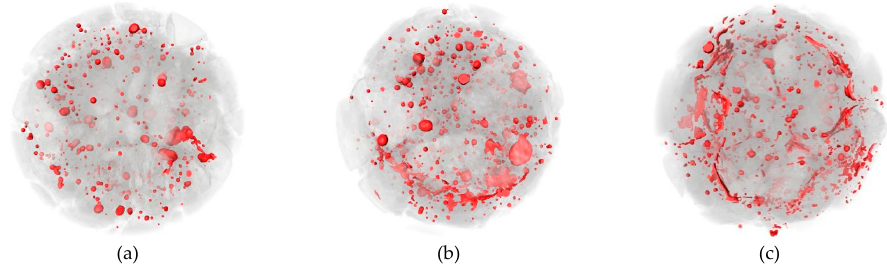
Figure 18. Pore distribution under different freezing and thawing cycles of 0.4% 30 nm-NS added concrete. ( a ) 25 FTCs; ( b ) 50 FTCs; ( c ) 75 FTCs.